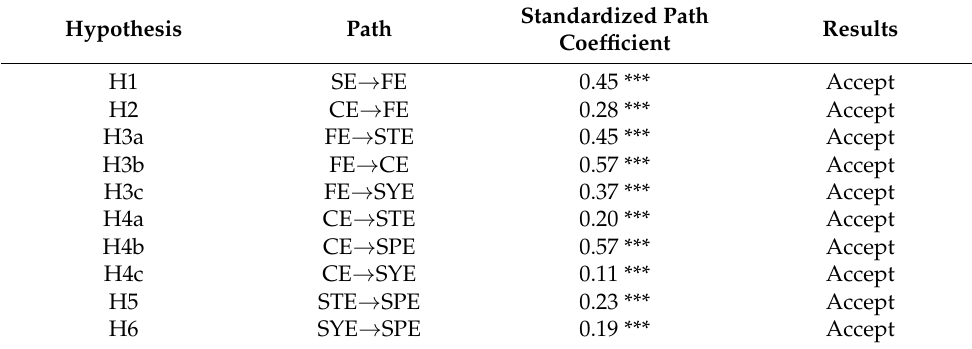
Table 4. Standardized path coefficients in hypothesis testing by structural equation